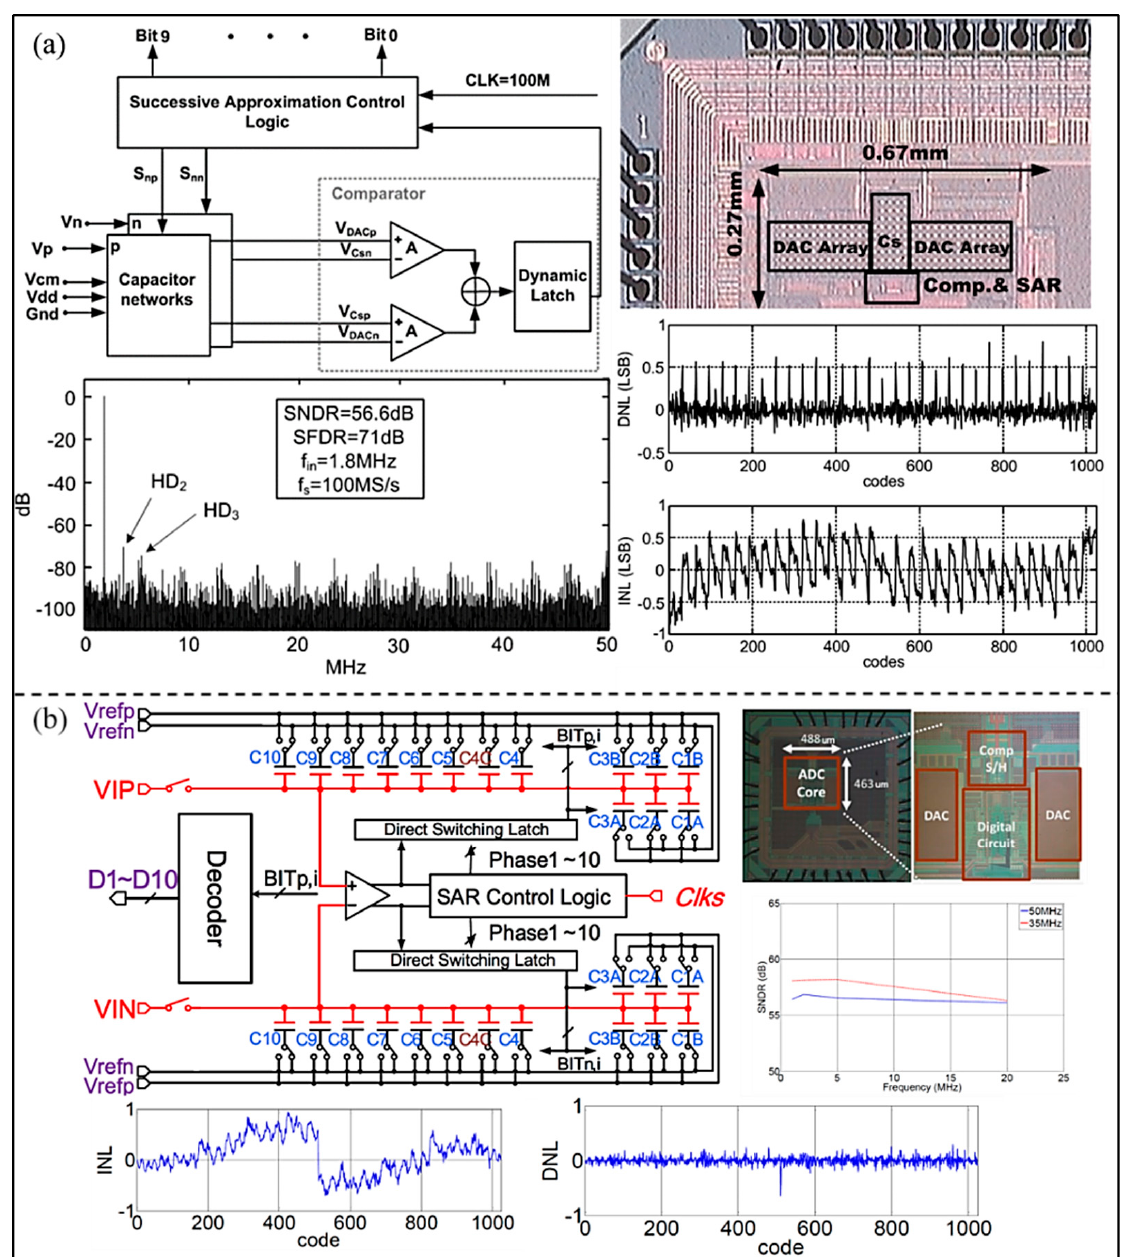
Figure 6. ( a ) Overall schematic diagram, die microphotograph, and the digital output FFT of the ADC. (Reprinted from [41], Copyright 2010, with permission from IEEE); ( b ) Architecture, die microphotograph, and measured results of the proposed SAR ADC. (Reprinted from [43], Copyright 2015, with permission from IEEE).